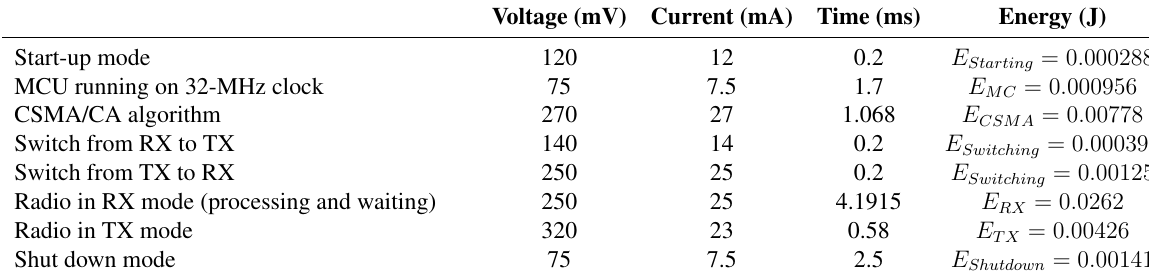
Table 3. Energy model